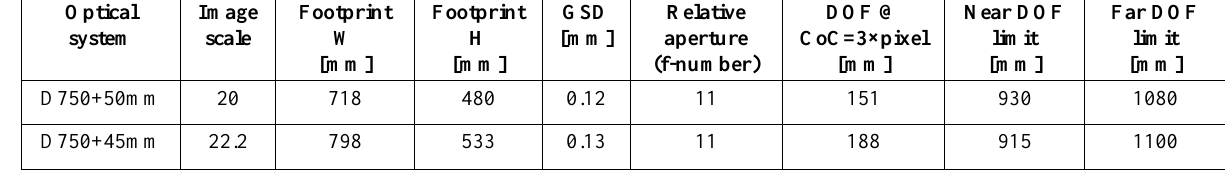
Table 2. Optical system set-up and measurement volume. The focus distance is fixed at 1 m. The system composed by the Nikon D750 and 50 mm lens is considered the reference photogrammetric system .